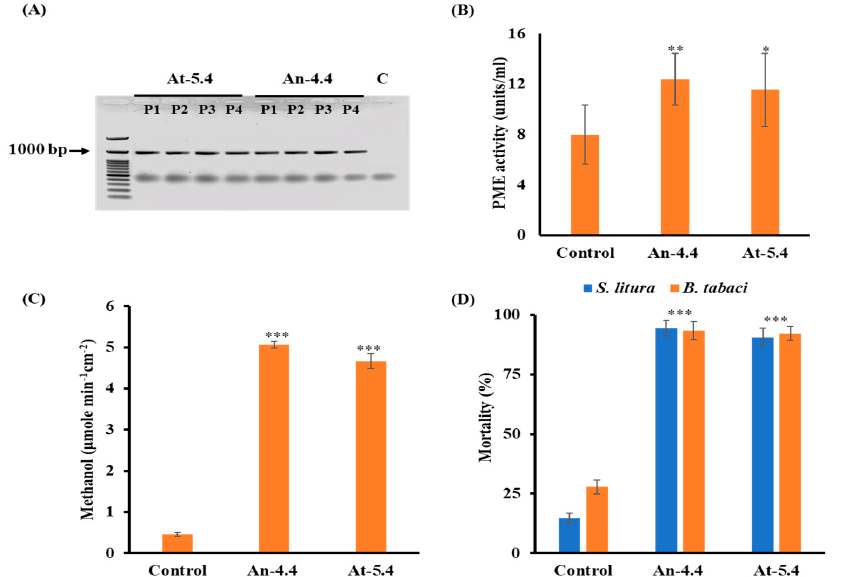
Figure 1. Molecular analysis of T4 generation transgenics. ( A ) Gel image showing cDNA PCR from At-5.4, An-4.4, and control. Arrow indicates band corresponding to atpme and anpme from four independent plants (P1-P4) of both transgenic lines. Graph showing ( B ) PME activity, ( C ) quantification of methanol emission in transpirated water through the stomata on leaves surface, in both transgenics and control plants. ( D ) Mortality of S. litura and whiteflies on At-5.4, An-4.4, and control plants after 6 days. * p < 0.05; ** p < 0.01; *** p <